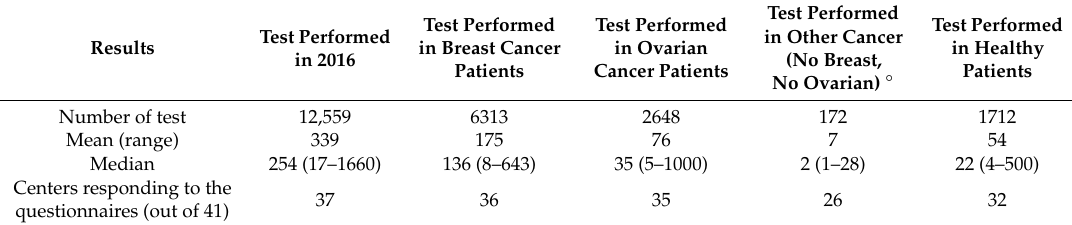
Germline BRCA1 / 2 assay performed by molecular laboratories in 2016 in di ff erent cancer settings.